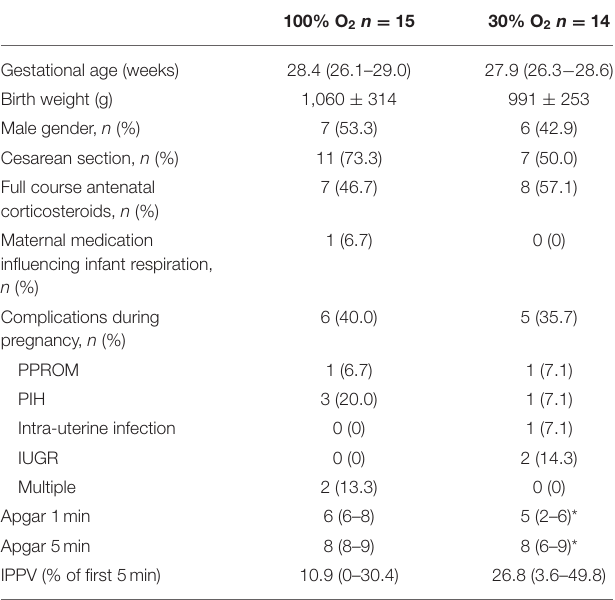
TABLE 1 | Subject characteristics of the